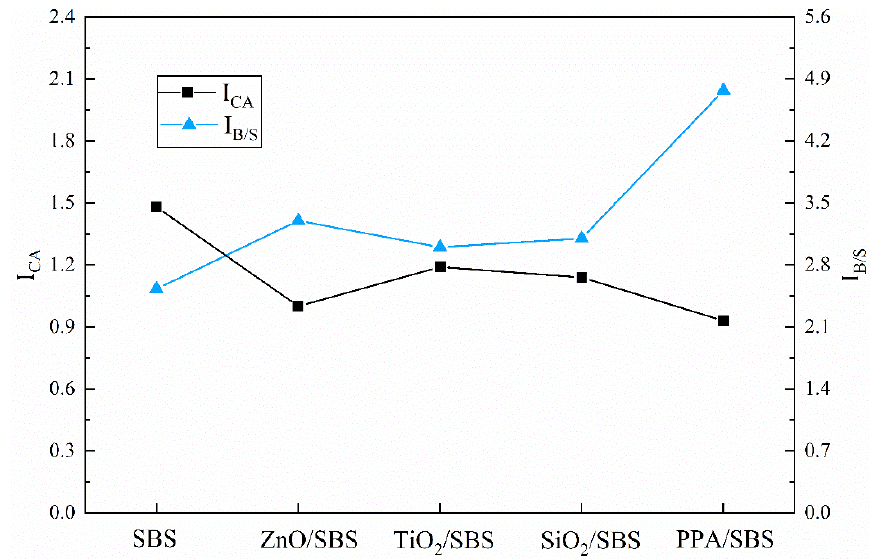
Figure 8. Quantitative analysis results of infrared spectra of different high content SBS composite modified asphalts under PAV aging state.